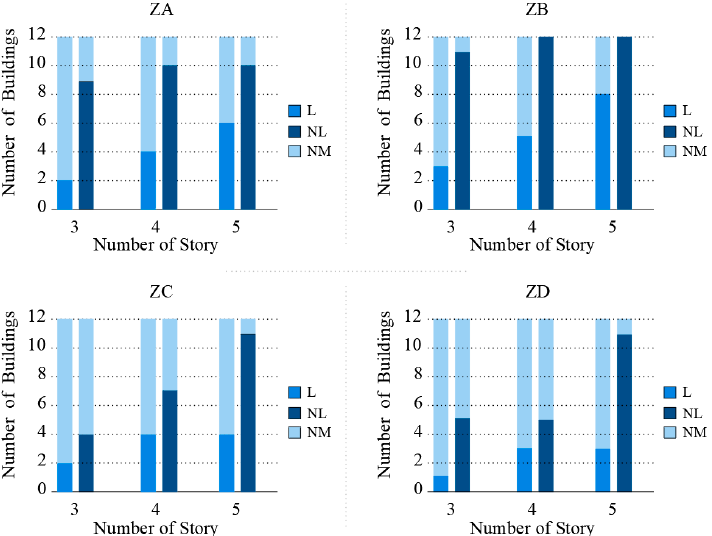
Figure 16. Distribution of buildings with sufficient performance according to the soil type / storey number.